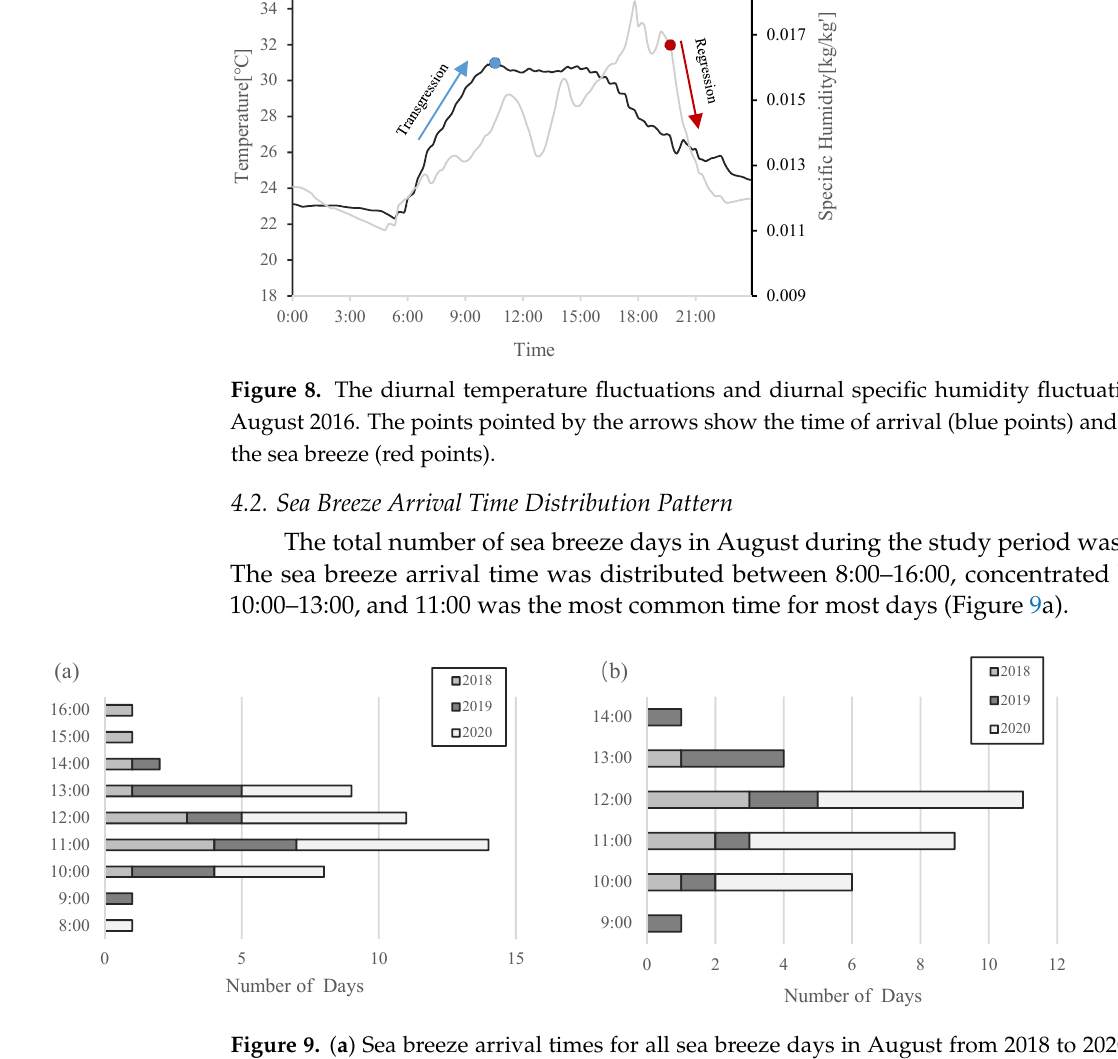
Figure 9. ( a ) Sea breeze arrival times for all sea breeze days in August from 2018 to 2020. ( b ) Sea breeze arrival times for August sea breeze days with maximum temperatures above 30